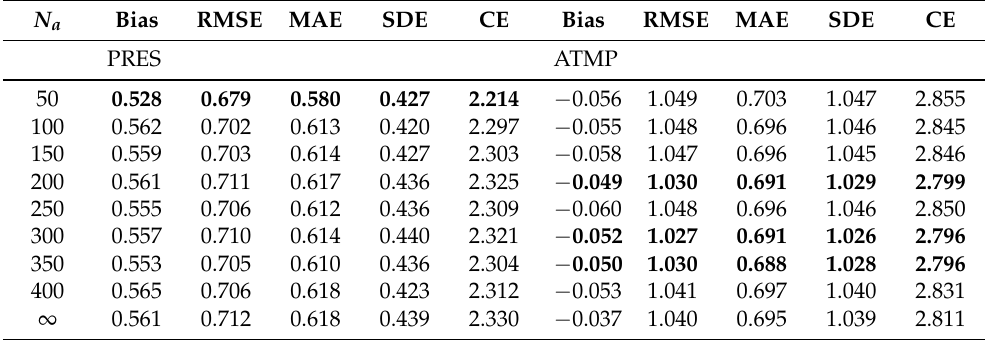
Table 3. Prediction errors as a function of the number of analogues ( N a